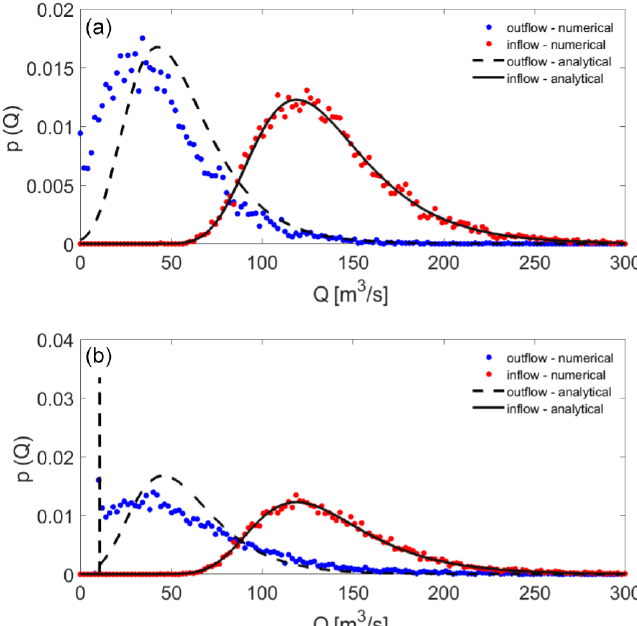
Figure 6. Comparison between derived probability density functions of the outflow (continuous black line for the inflow and dashed black line for the outflow) and the empirical PDFs obtained via numerical hydraulic simulation (red dots for inflow and blue dots for outflow) obtained by assuming the absence (a) or the presence (b) of the low-level opening. Remaining parameters are α = 30m 3 /s; β = 120m 3 /s; w 1 = 6500; h s = 10m; b = 1m; d = 1m; n = 1 . 9; h f = d/ 2; µ f = 0 . 85; µ s = 0 . 385; L = 4m; t p =